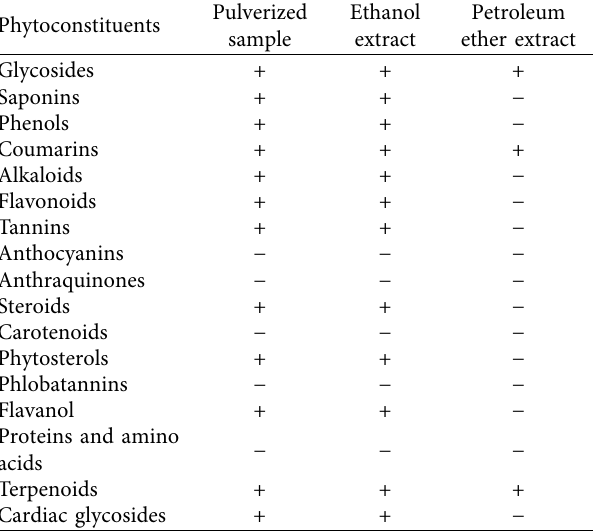
Table 1: Phytoconstituents present in the pulverized sample and extracts of C. nioroense